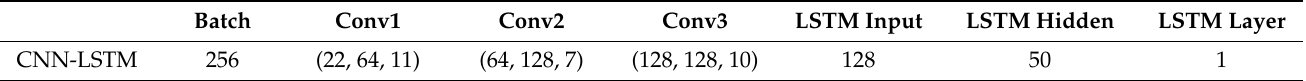
Table 4. Parameter setting of CNN-LSTM.